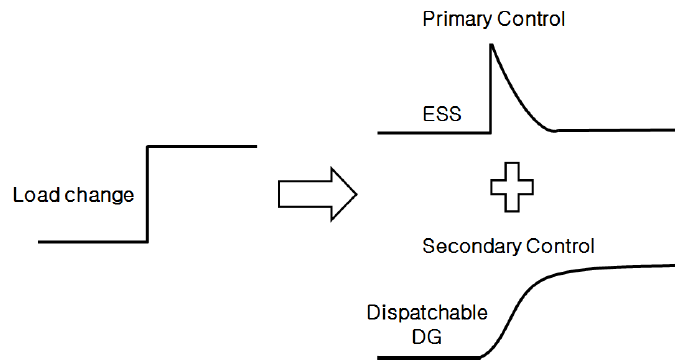
Figure 2. Concept of coordinated control of ESS and